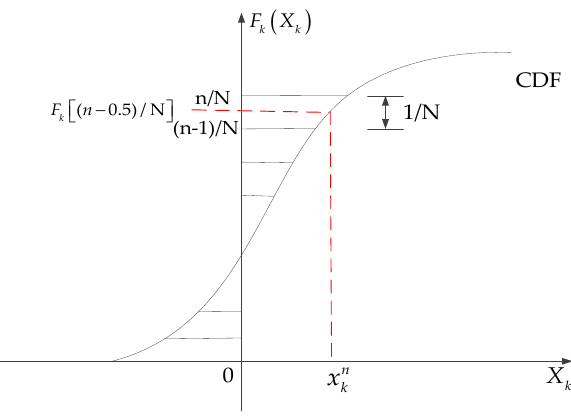
Figure 1. Sampling procedure of the Latin hypercube sampling (LHS) method.